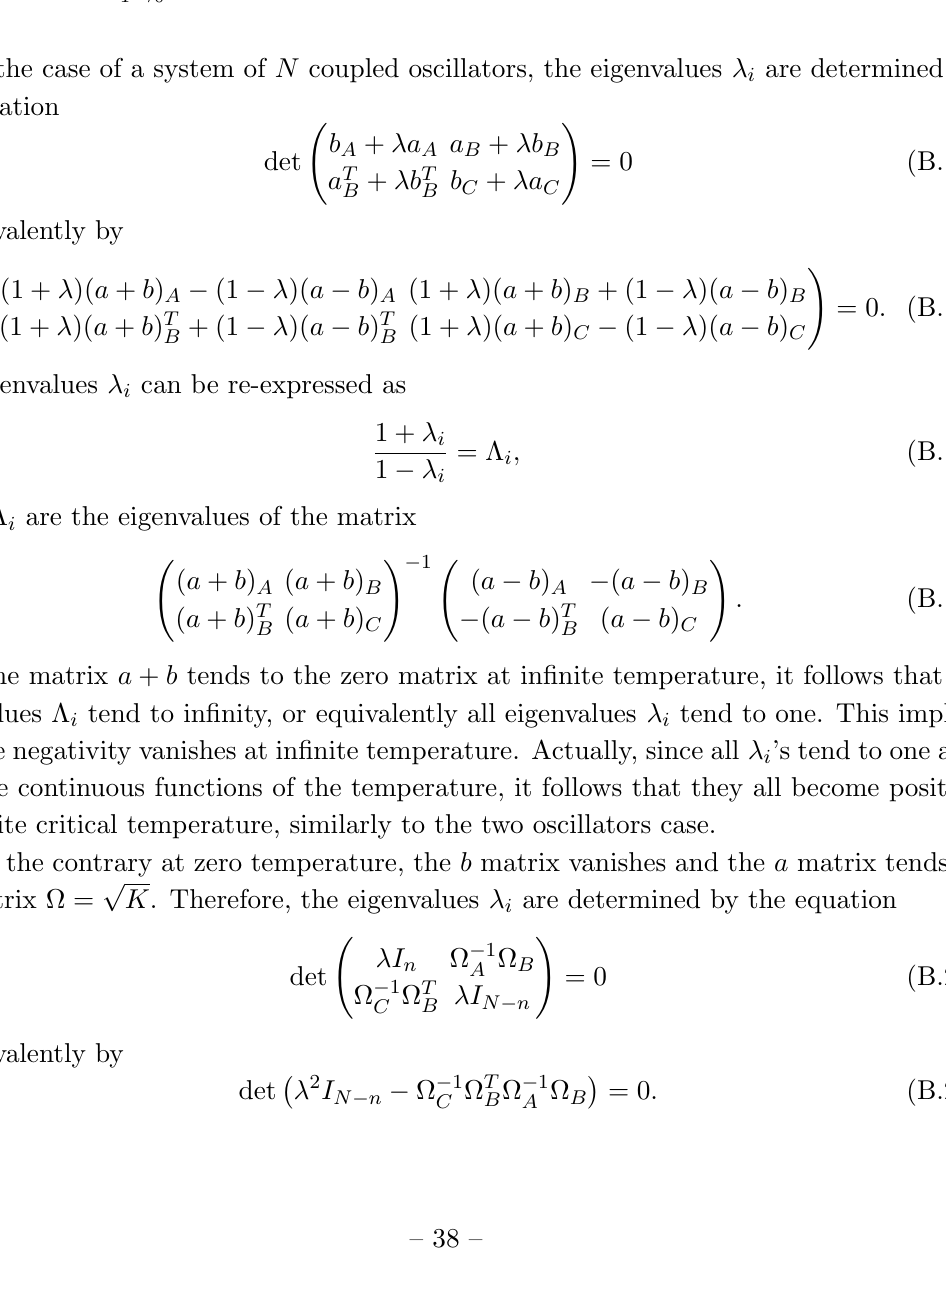
Figure 8 . The eigenvalues of the partially transposed density matrix (left) and the entanglement negativity (right), as functions of the temperature. For these plots it is assumed that ! (cid:0) =! + = 3 = 2, which implies that lim (cid:21) = (cid:6) 1 1 = 2 5 T ! 0